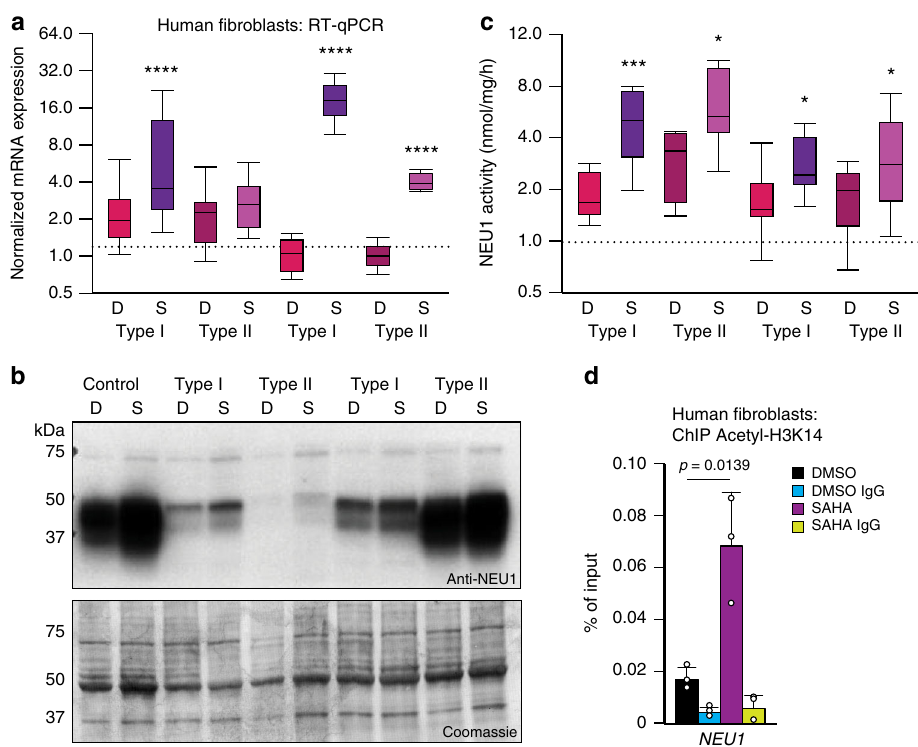
Fig. 8 HDAC inhibition in LSD. a RT-qPCR of NEU1 in SAHA- or DMSO-treated sialidosis fi broblasts, (SAHA 20 μ M for 24 h; n = 8 biologically independent samples). Type I = attenuated form of sialidosis; Type II = severe form of sialidosis. b Top, representative immunoblot of fi broblasts isolated from two patients with sialidosis type I and two patients with sialidosis type II were treated with SAHA (S) (20 μ M for 24 h) or DMSO (D) and probed with anti- NEU1 antibody; bottom, Coomassie stained immunoblot used as loading control. c NEU1 activity in fi broblasts isolated from two patients with sialidosis type I and two patients with sialidosis type II treated with SAHA (S)- or DMSO (D)-treated (SAHA, 20 μ M for 24 h; n = 7 biologically independent samples). d ChIP analysis of the promoter of NEU1 performed with acetyl histone H3 Lys 14 antibody (Acetyl-H3K14) in fi broblasts from one type I sialidosis fi broblasts treated with SAHA (20 μ M for 24 h) or DMSO ( n = 3 biologically independent samples). Boxes represent the mean value and bar inside the box represents median value; upper bar represents maximum of distribution; lower bar represents minimum of distribution (95% con fi dence level). Graphs are presented as mean ± SD. Statistical analysis was performed using the Student t -test. * p < 0.05, *** p < 0.001, **** p < TFE axis to repress their lysosomal and autophagy systems, a paradigm that may be exploited therapeutically. In fact, HDAC inhibitors have recently shown therapeutic potential in group 3 medulloblastoma, as a single-agent therapy 72 or in combination with PI3K inhibitors 73 . Given that HDAC inhibitors increase FOXO1 expression, thereby inhibiting tumor growth, and that silencing FOXO1 dampens this effect, we are tempted to speculate that autophagy and lysosomal biogenesis activated by MiT/TFE and/or FOXH1 may be the pathways of choice for targeted cancer therapy. Future studies will reveal the generality of our rheostat model in different cancer types, and how it contributes to tumor initiation, progression and maintenance.